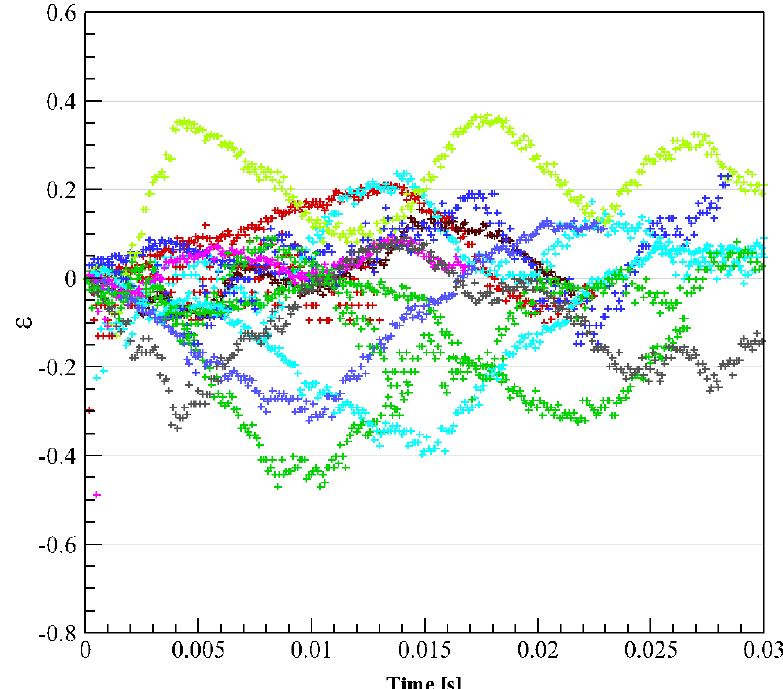
Figure 8. Deformation rate, (cid:101) , is shown over time for several marked bubbles at V ∞ = 3 m/s, Q = 5 SLPM .